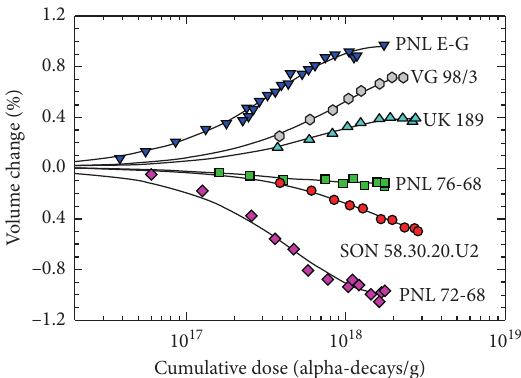
Figure 5: Dependence of the change in the specific volume of glass (volume swelling and compaction) on the dose of α -radiation caused by decay of 244 Cm